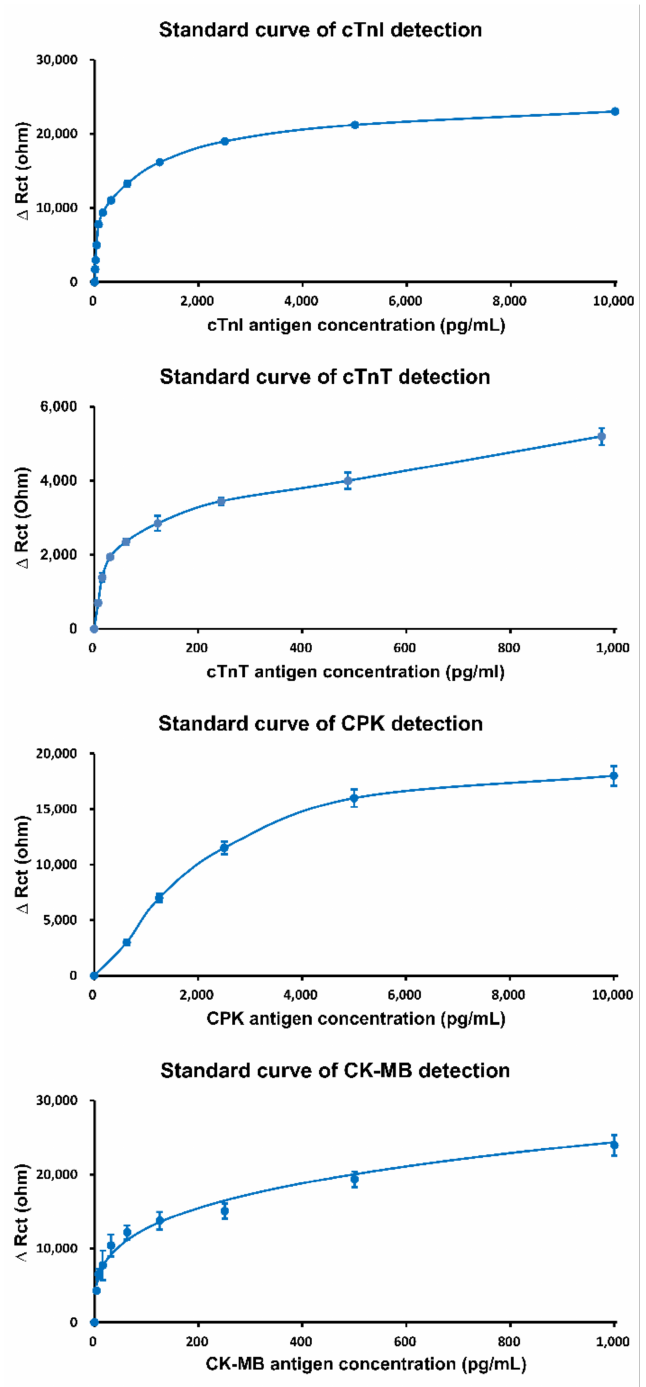
Figure 3. The performance of the AllCheck ®